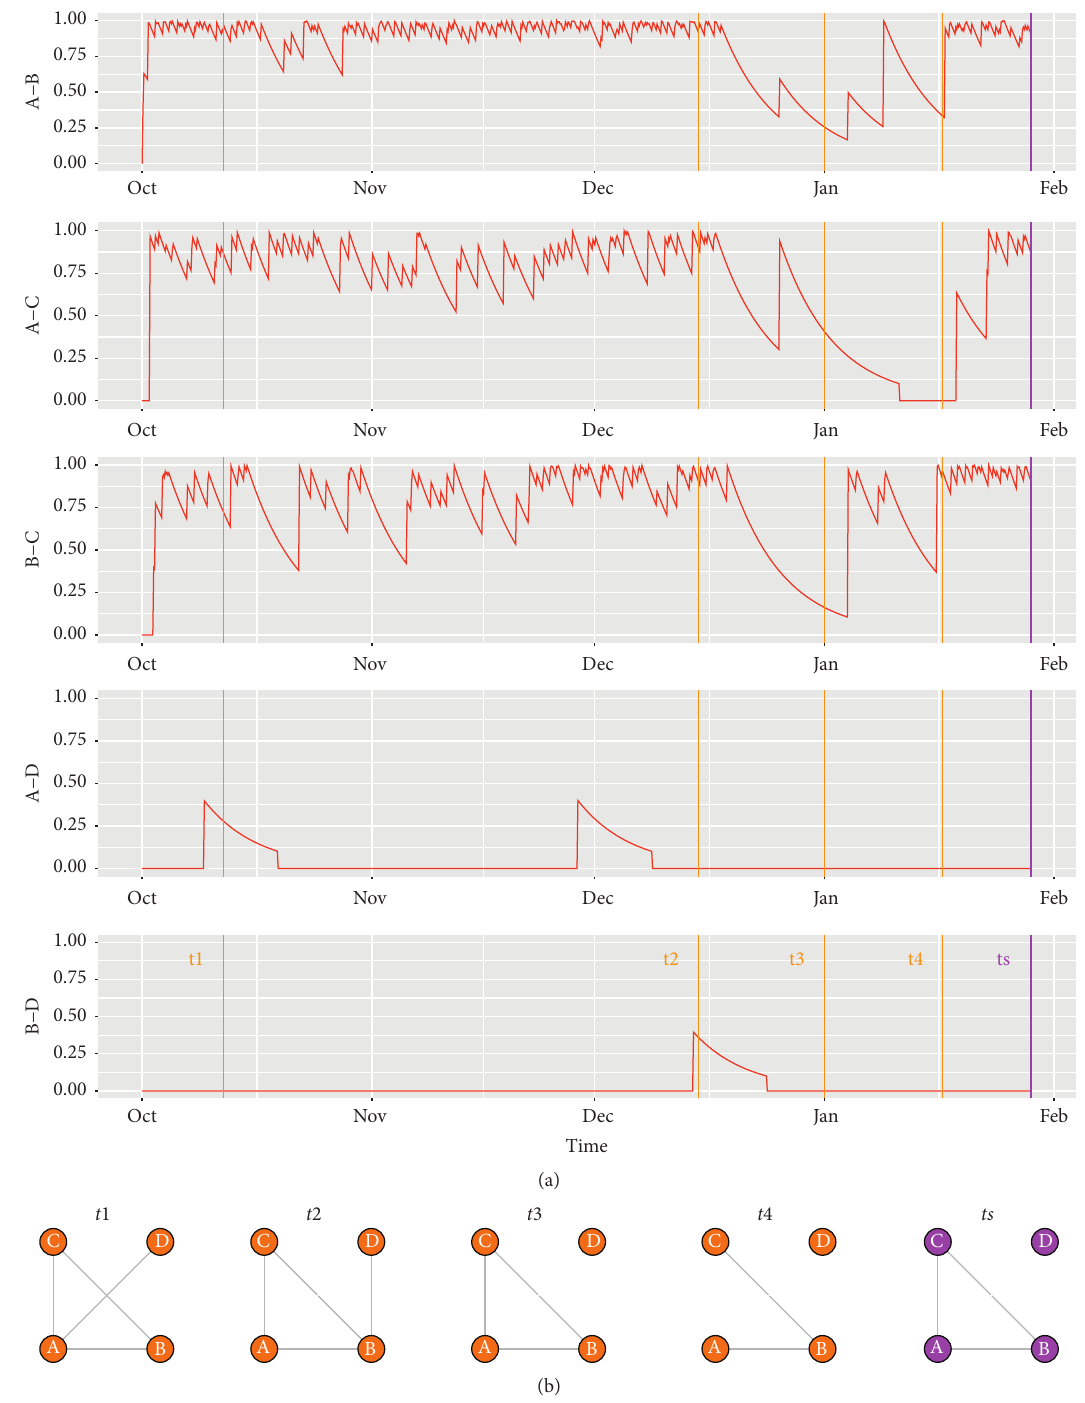
Figure 3: Four-node CogSNet network for the sample of real NetSense data: μ � 0 . 4, θ � 0 . 1, and L � 10 days; nodes A, B, C, and D correspond, respectively, to participants with ids 40997, 11360, 10841, and 1232. (a) Relation strengths according to the CogSNet model over 4-month period (one term); (b) network snapshots at four timestamps t